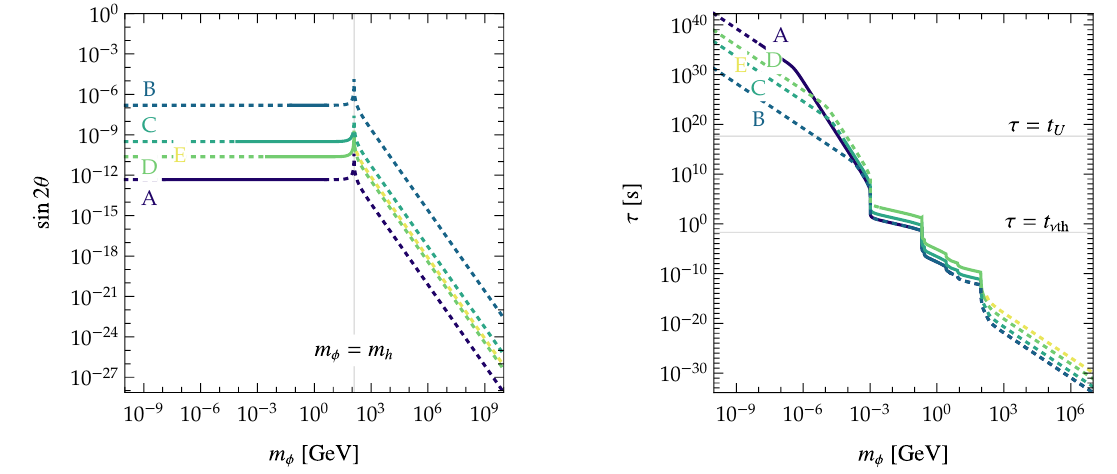
Figure 13 . Relaxion-Higgs mixing angle (left) and relaxion lifetime (right), for scenarios A-E de(cid:12)ned in eq. (5.28). The solid lines correspond to the mass range allowed in our model once the constraints discussed previously are applied, see eq. (6.3). The two horizontal lines in the right panel correspond to the age of the universe t U and to t (cid:23) th , which is the bound given by the neutrino thermalisation (see section